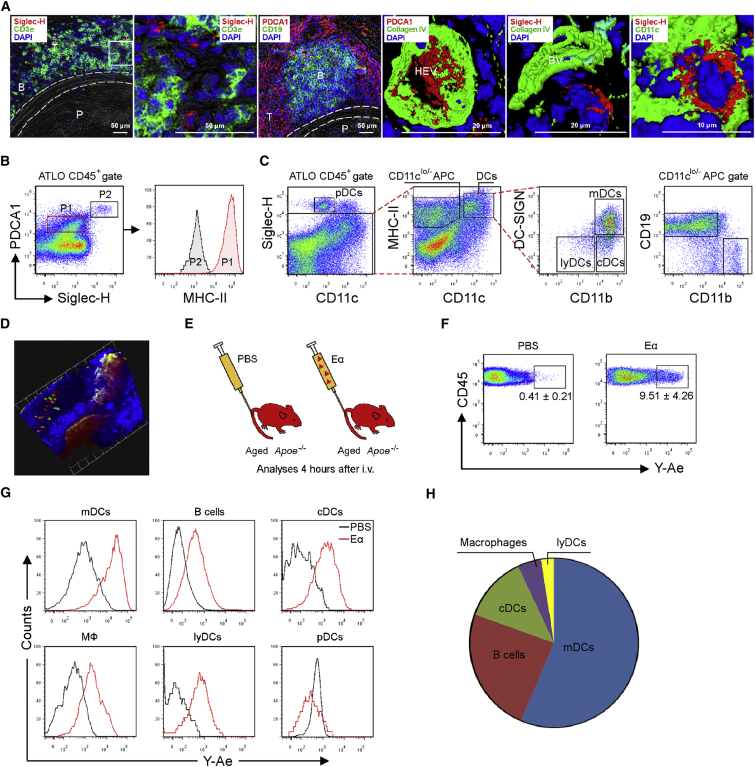
ATLOs Present Antigen by an Unusual Set of APCs(A) PDCA1+ and Siglec-H+ cells in ATLOs. Immunofluorescence staining show preferential location of Siglec-H+ pDCs in CD3+ T cell area (T) of ATLO and at higher magnification of boxed area (first two panels), the staining of PDCA1+ cells in ATLO T cell area and 3D-reconstructed colocalization of PDCA1 with Collagen IV in HEV endothelial cells (second two panels), and 3D-reconstructed co-staining of Siglec-H with Collagen IV in ATLO blood vessels (BV) and CD11c (third two panels; n = 3 mice).(B) pDCs are MHC-IIlo. Flow cytometry analyses show co-staining of PDCA1 and Siglec-H on ATLO CD45+ cells (left) and MHC-II expression on PDCA1loSiglec-H− cells (P1) and PDCA1hiSiglec-H+ cells (P2)(right).(C) Gating strategy for APCs. Flow cytometry plots show the gating strategy for APC subtypes in pre-gated CD45+ cells from plaque-removed abdominal aorta.(D) OT-II T cells-ATLO cDC interactions. 3D image of ATLO OT-II T cell-DC interactions in situ (n = 8 mice). Grid Unit = 42.6 μm. Projection: Lumen toward adventitia. T cells are red, DCs are green (see also Movies S3 and S4).(E) Approach for Eα or PBS injection.(F) Y-Ae+ cells in ATLOs. Flow cytometry plots indicate Y-Ae+ cells among CD45+ cells from plaque-removed ATLO-bearing abdominal aorta segments as in C.(G) Y-Ae+ APC subtypes. Histograms show comparisons of Y-Ae expression in mDCs, B cells, cDCs, macrophages, lyDCs and pDCs from PBS- or Eα-GFP-injected mice.(H) Composition of ATLO APCs. Pie chart depicts the composition of Eα-presenting APCs in ATLOs (recipient mice 78- to 85 weeks old, donor OT-II mice 9- to 12 weeks old). Flow cytometry data are representative of four experiments with one mouse per genotype per experiment (B, C, and E–H).